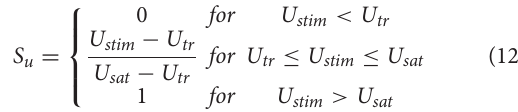
( Figure 2 , top) are described